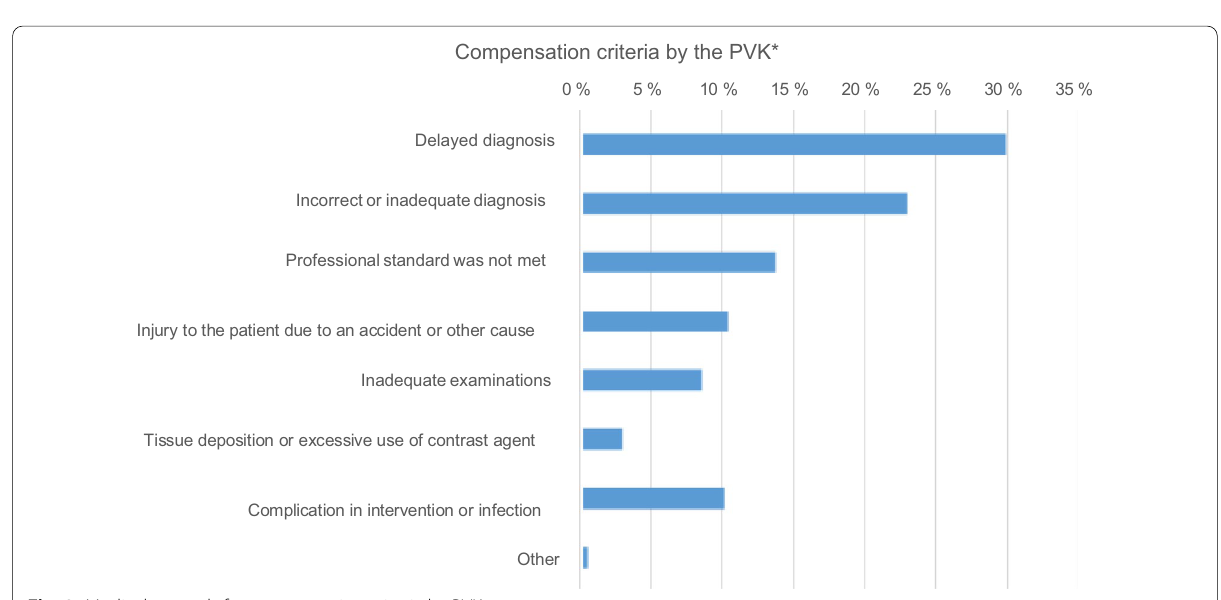
a The Finnish Patient Insurance Centre b Thyroid, muscles